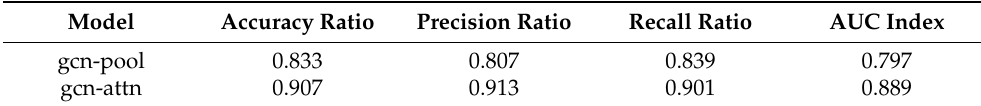
Table 5. Average results of four evaluation metrics based on the LINUX dataset.